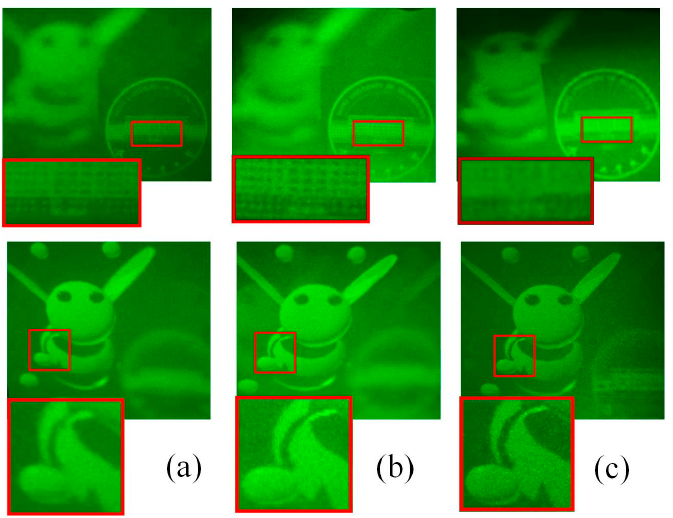
Figure 6. The optical reconstruction results with capturing depth ( a ) L = 80 mm, ( b ) L = 45 mm, and ( c ) L = 30